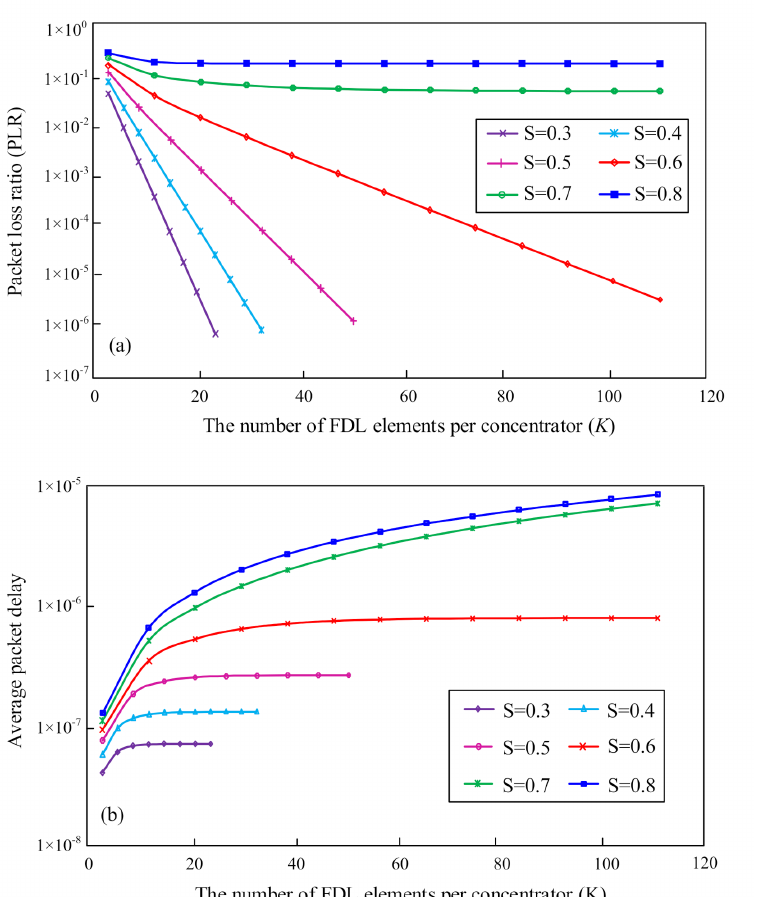
Figure 7. Packet loss ratio (PLR) and the average packet delay versus the buffer size offered per concentrator. ( a ) PLR versus buffer size per concentrator; ( b ) the average packet delay versus buffer size per